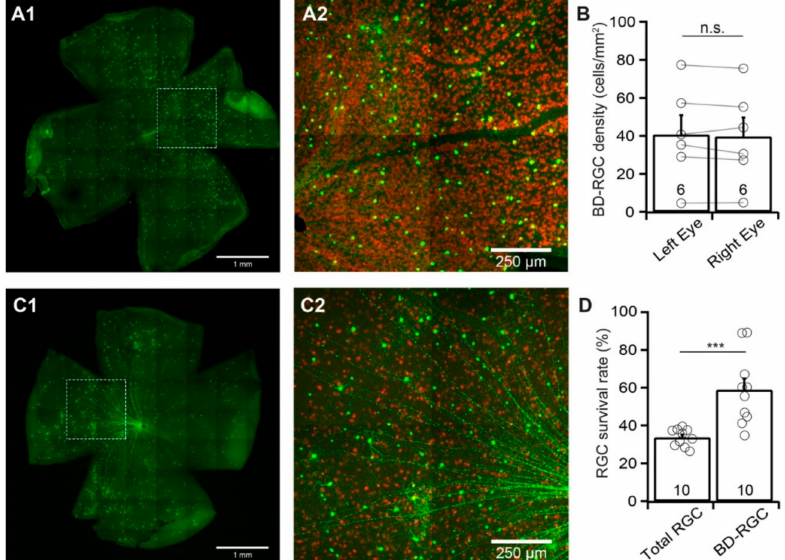
Figure 3. The vulnerability of BD-RGCs to ONC. To determine the susceptibility of BD-RGCs to ONC, we clamped the optic nerve of the left eyes of BD:YFP mice. We quantified the density of YFP-expressing BD-RGCs of the left eyes seven days after ONC and compared results with the density of YFP-expressing BD-RGCs of the uninjured right eyes of the same group of BD:YFP mice. ( A ) A representative image of a flat-mount BD:YFP mouse retina without ONC ( A1 ) only showing YFP-expressing BD-RGCs but not anti-RBPMS-labeled RGCs, and a magnified view of the dash-line box of A1 to show the anti-RBPMS staining of all RGCs (red) and YFP-expressing BD-RGCs (green) ( A2 ). ( B ) Comparison of the average densities of YFP-expressing BD-RGCs of uncrushed right and left eyes of the same group of BD:YFP mice. The di ff erence between the right and left eyes is not statistically significant (number of mice n = 6, paired t -test, p = 0.4). The circles are individual eyes. n.s.: not significant. ( C ) A representative image from the retina of a BD:YFP mouse with the labeling of YFP-expressing BD-RGCs (green) 7 days after ONC ( C1 ) and a magnified view of the boxed area in C1 with labeling of both YFP-expressing BD-RGCs (green) and RGCs labeled by anti-RPBMS antibody (red, C2 ). ( D ) Comparison of the average survival rates of anti-RBPMS-labeled RGCs and YFP-expressing BD-RGCs from the same eyes seven days after ONC. The densities of anti-RBPMS-labeled and YFP-expressing BD-RGCs of the eyes with ONC were normalized to their uncrushed control eyes for each mouse. The survival rates of YFP-expressing BD-RGCs are significantly higher than that of anti-RBPMS-labeled RGCs from the same eyes (number of mice n = 10, paired t -test, p = 0.0005). *** p < 0.001. The circles are individual